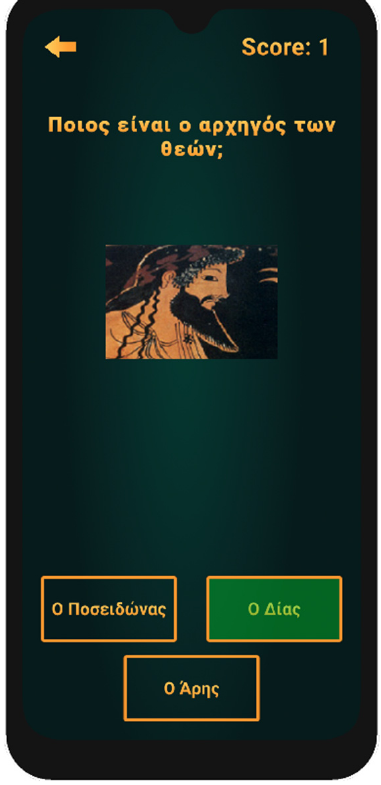
Figure 8. Correct answer in the “Quiz game”.